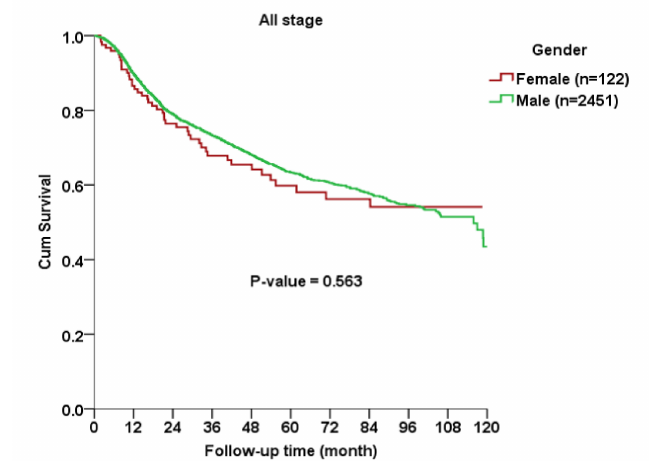
Figure 1. Kaplan–Meier curve for overall survival rates between female and male patients with oral squamous cell carcinoma.